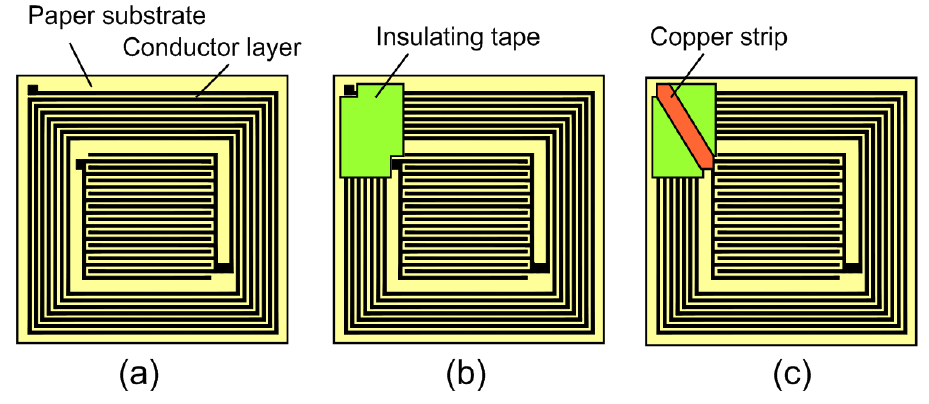
Figure 5. The fabrication process of the sensor. (a) The bottom conductor layer was patterned, followed by (b) applying the insulating layer and (c) the top conductor strip to complete the resonant